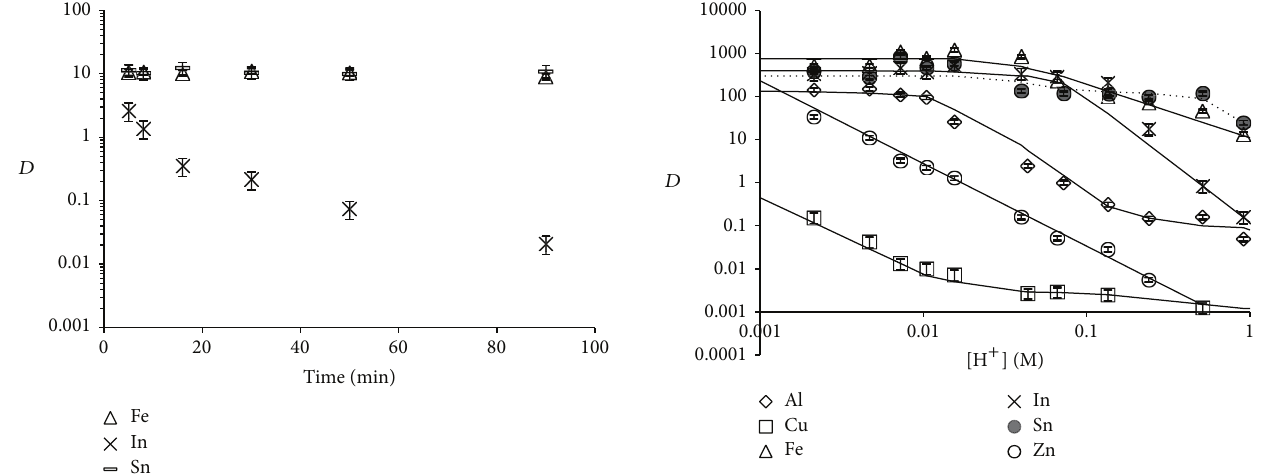
Figure 3: Kinetics of metal back-extraction from loaded 0.1M D2EHPA in kerosene into 1M HCl at 𝜃 = 1 . Mixing time of the mixtures was between 5 minutes and 2.5 hours at 1500 rpm and 293 ± 2 K.